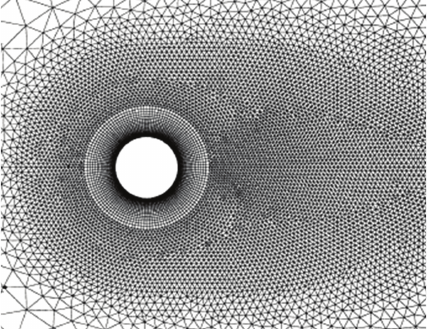
Figure 5: Unstructured triangular grids around the